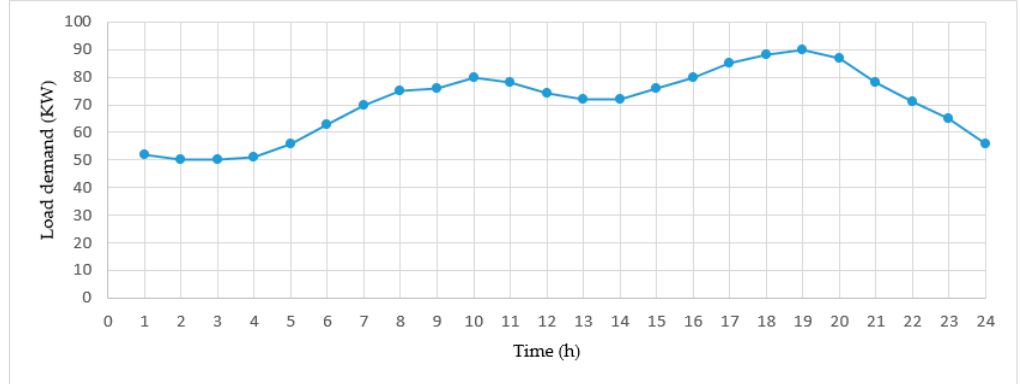
Figure 9. The bid degrees of the installed distributed generators. Energies 2020 , 13 , x FOR PEER REVIEW